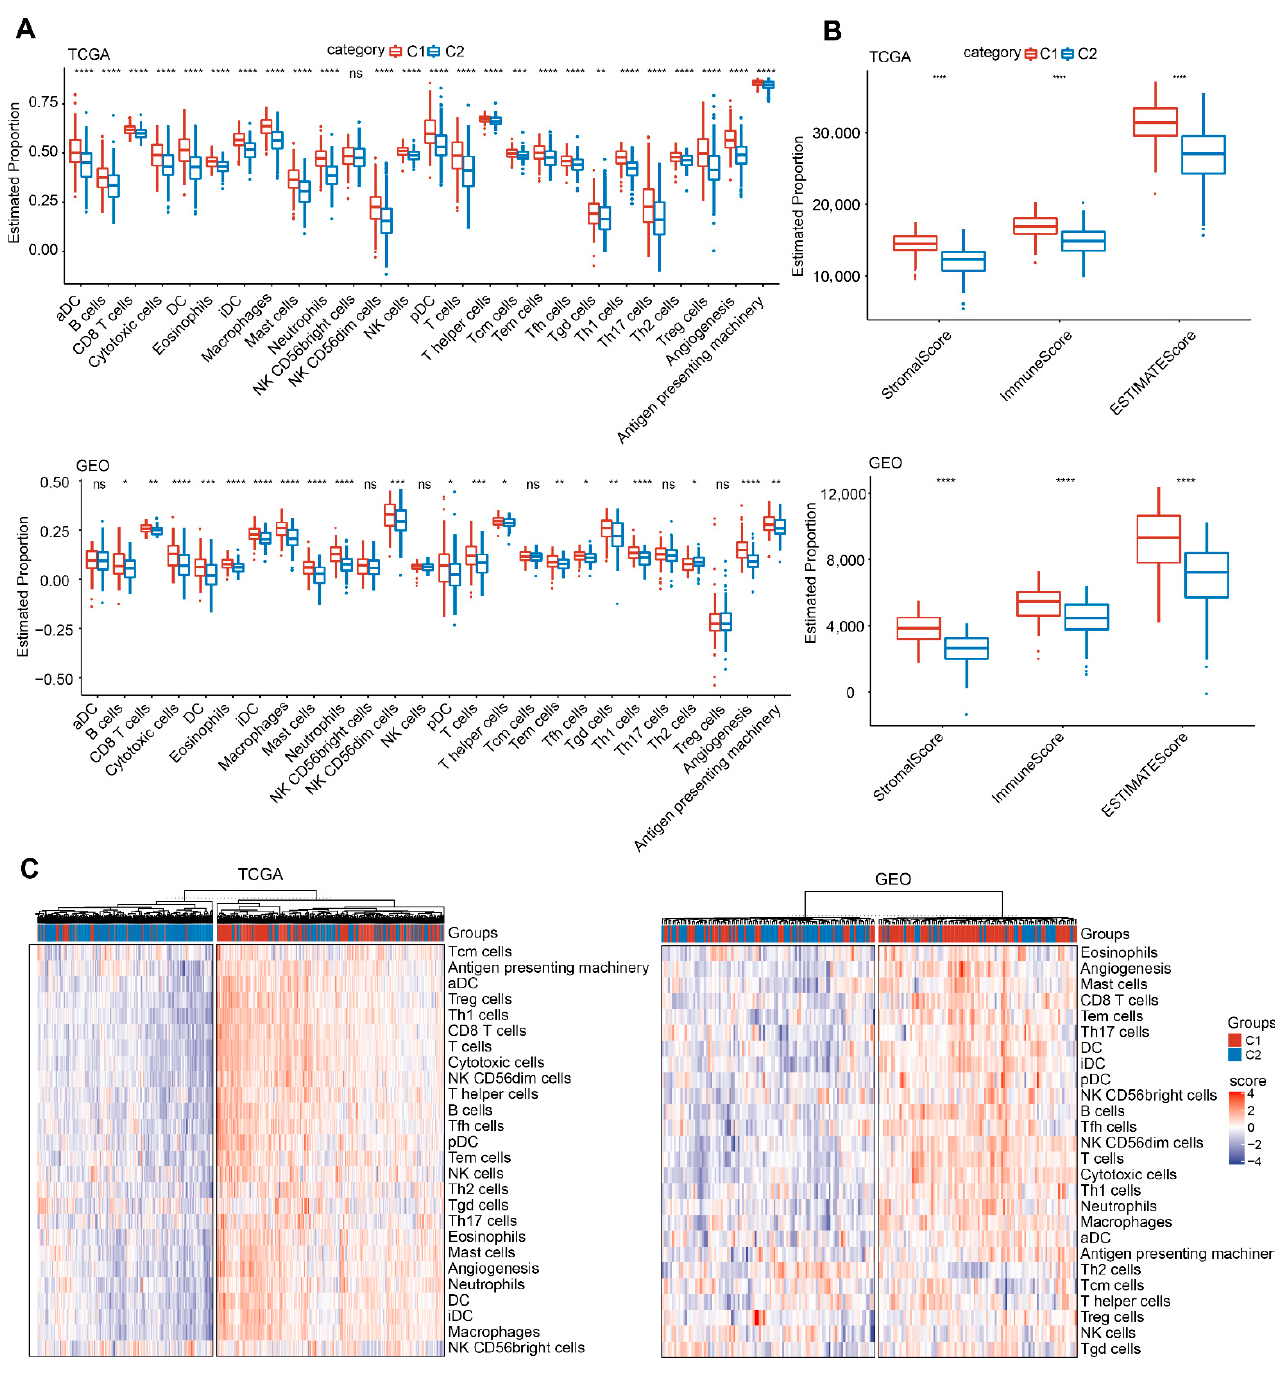
Figure 5. The immune characteristics of EMT-associated LncRNAs. ( A ) Proportion of immune cell components in two Lung SCC cohorts. ( B ) The proportion of immune cell components calculated by ESTIMATE software. ( C ) Unsupervised clustering of distinct immune cell infiltrations in EMT- stratified cluster 1 and cluster 2 cancer patients. Ns; p >0.05; * 0.01 ≤ p < 0.05; ** p < 0.01, *** p < 0.001, **** p < 0.0001.